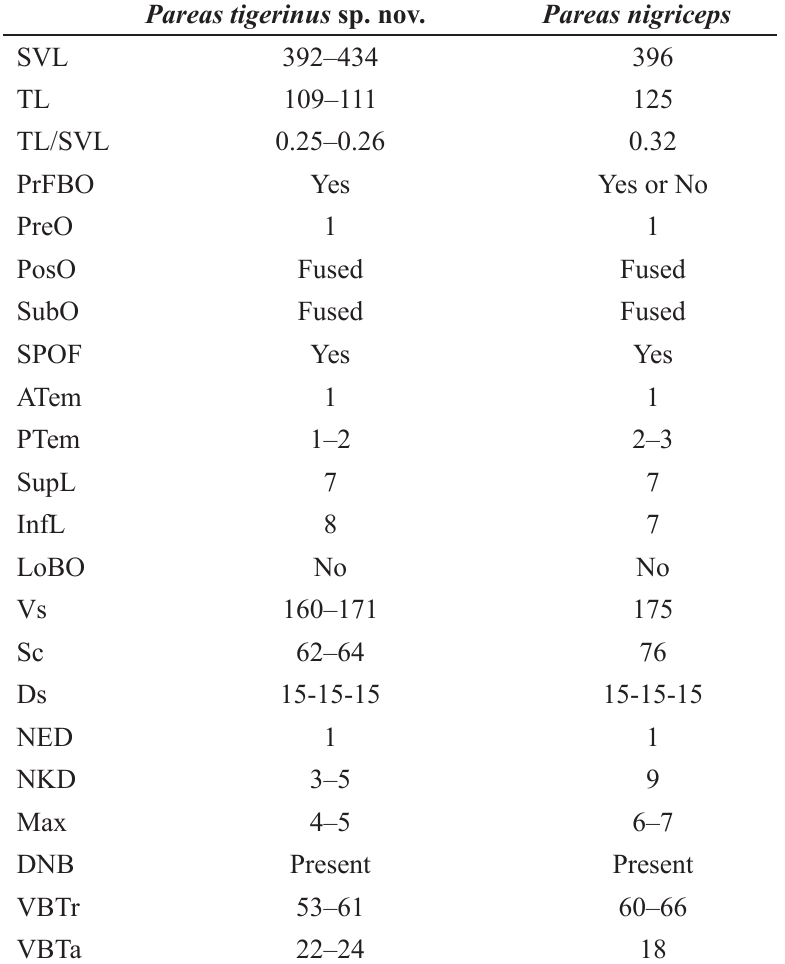
Table 6. Comparisons of morphometric and meristic data for Pareas tigerinus sp. nov. and P. nigriceps Guo & Deng, 2009. Measurements in mm, data for P. nigriceps from Guo & Deng